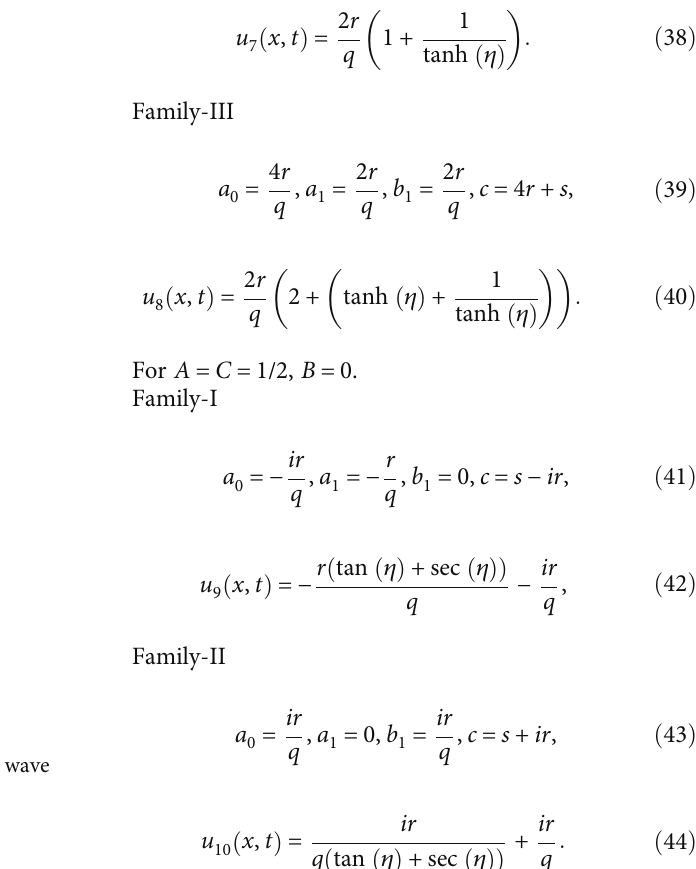
Figure 4: 2D and 3D graphics for hyperbolic traveling wave solution (30) at f β = 0 : 5, r = 1, q = 1, c = 1 g .